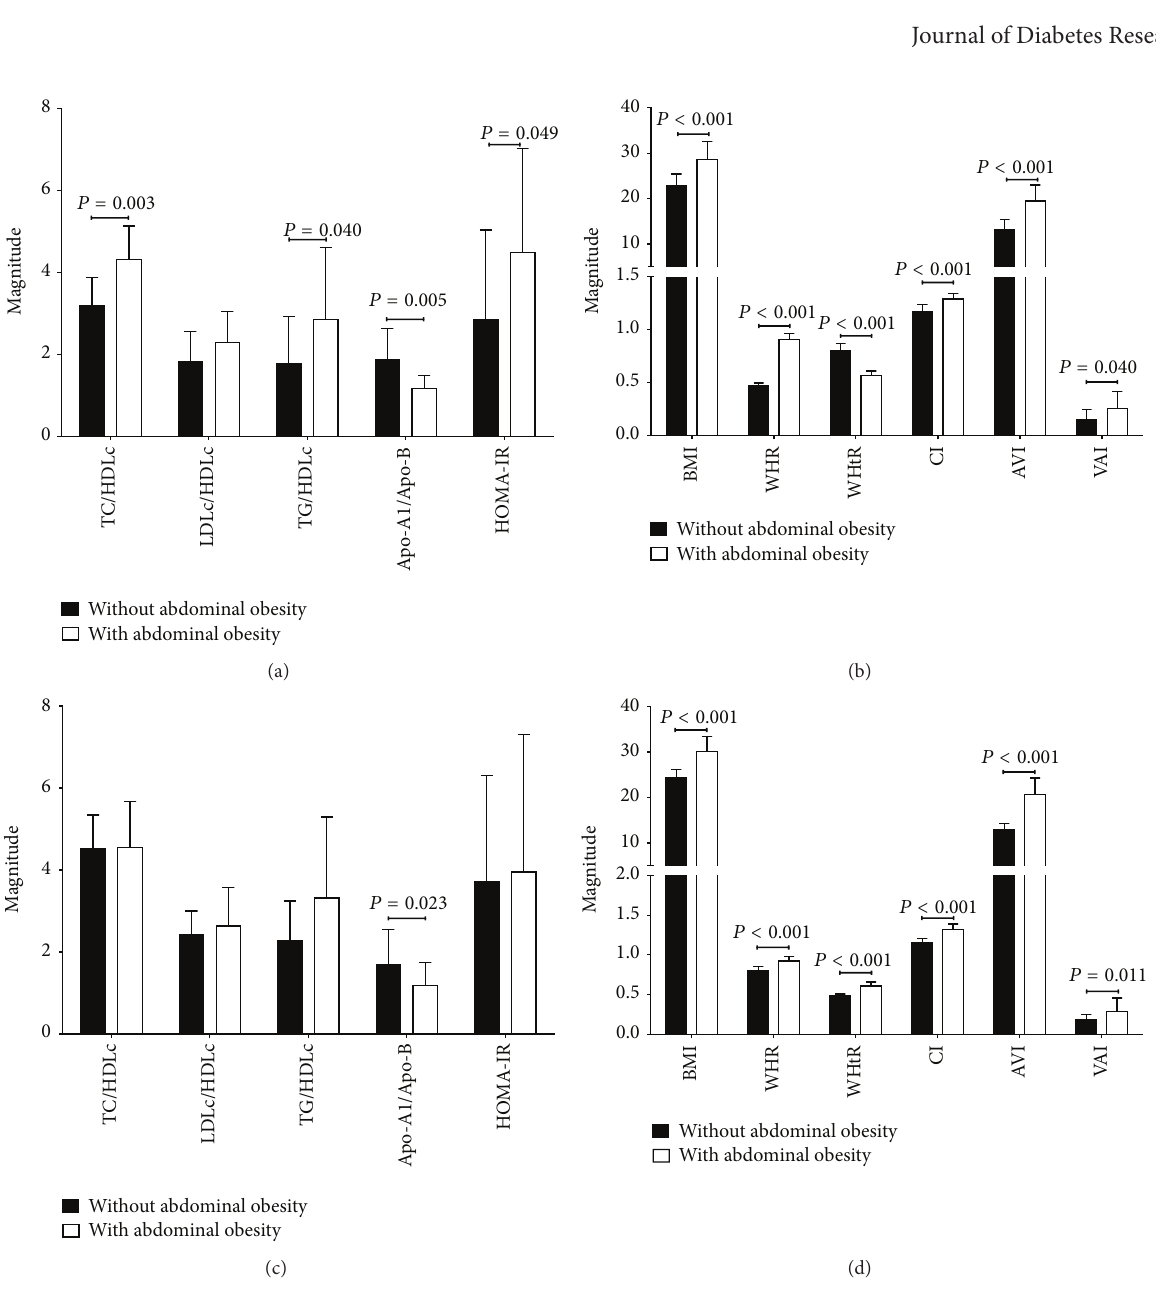
Figure 1: Metabolic and adiposity indexes in study group. Subjects without abdominal obesity: 𝑛 = 33; subjects with abdominal obesity: 𝑛 = 118. Data are presented as mean ± SD. (a) and (b) Individuals < 30 years old: Mann-Whitney 𝑈 test comparing the groups with abdominal obesity versus individuals without abdominal obesity. (c) and (d) Individuals ≥ 30 years old with abdominal obesity versus individuals without abdominal obesity. TC: total cholesterol; HDLc, LDLc, and VLDLc: high density lipoprotein cholesterol, low density lipoprotein cholesterol, and very low density lipoprotein cholesterol, respectively; Apo: apolipoprotein; HOMA-IR: homeostasis model assessment-insulin resistance; BMI: body mass index; BFR: body fat ratio; WHtR: waist-to-height ratio; CI: conicity index; AVI: abdominal volume index; VAI: visceral adipose